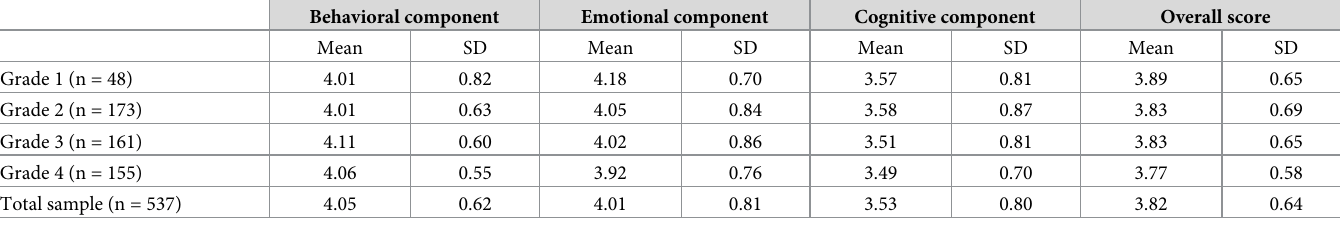
Table 3. Descriptive statistics for each component and an overall score of school engagement ( n =